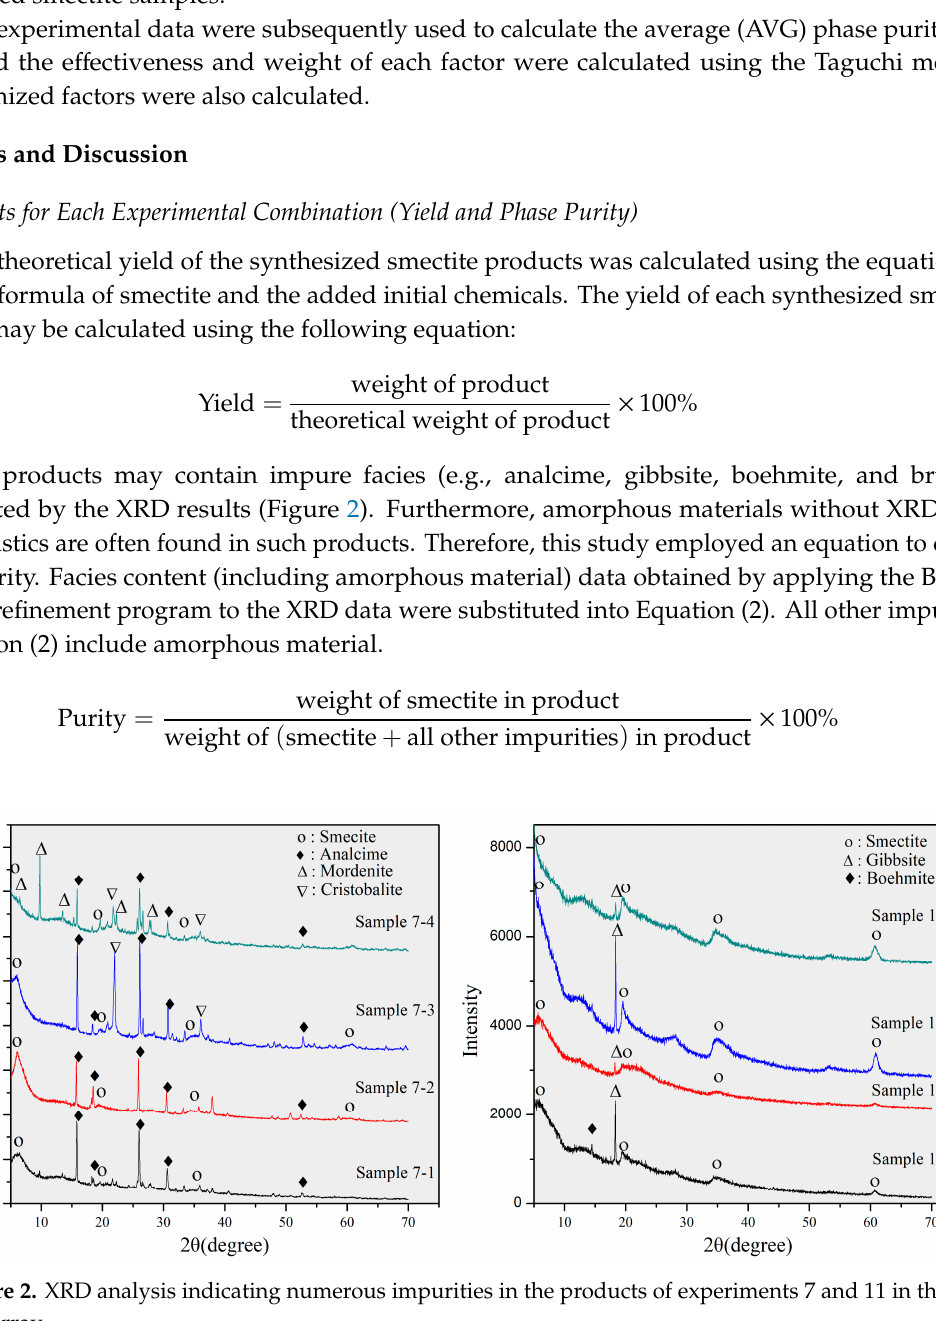
Table 4. Phase purity (%), average (%), and SD (standard deviation) of the synthesized smectites in the experimental combinations.